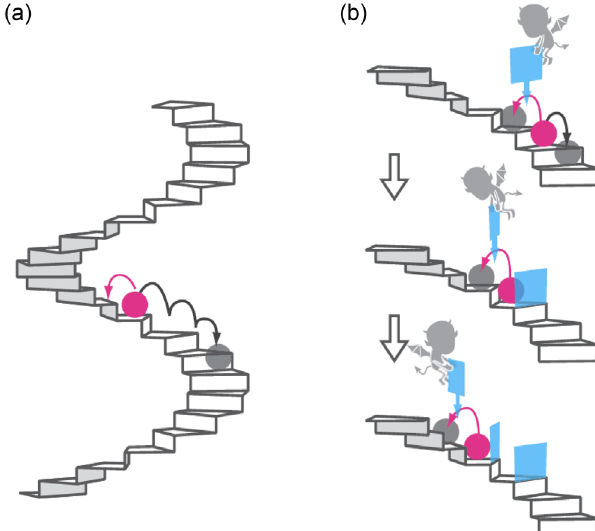
FIG. 14. (a) Experimental realization of Szilard ’ s engine. (a) A colloidal particle in a staircase potential moves downward on average, but energy fluctuations can push it upward from time to time. (b) When the demon observes such an event, it inserts a wall to prevent downward steps. By repeating this procedure, the particle can be brought to move upwards, performing work against the force created by the staircase potential. In the actual experiment, the staircase potential is implemented by a tilted periodic potential and the insertion of the wall is simply realized by switching the potential, replacing a minimum (no wall) by a maximum (wall) (adapted from Ref.